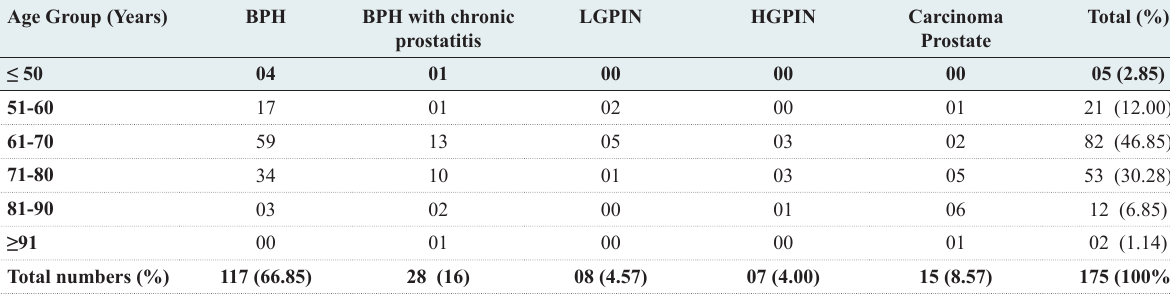
Table 2: Serum PSA levels in different prostatic